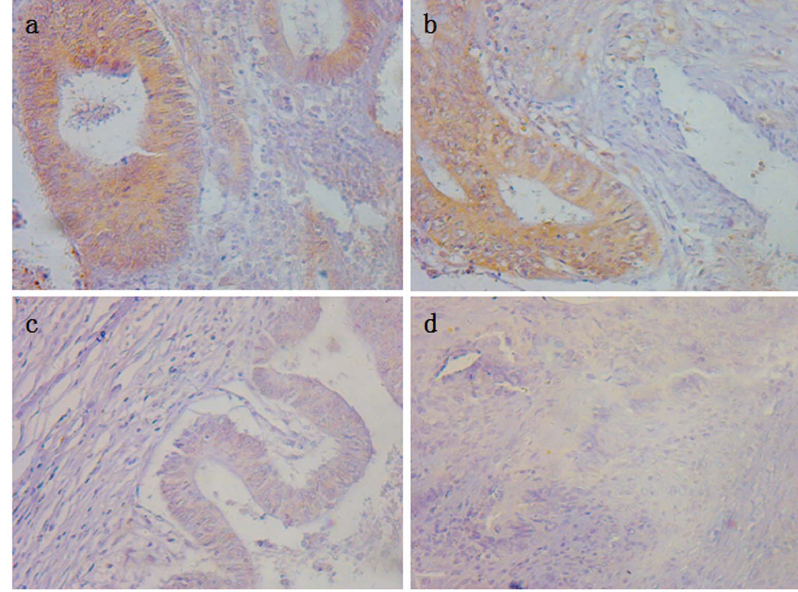
Figure 2. Representatives of TCF3 expression in stage II and III CRC tissues detected by immunohistochemistry. Examples of the immunostaining of TCF3 at strong expression (a, b) and low expression (c, d) levels (magnification 6 400).